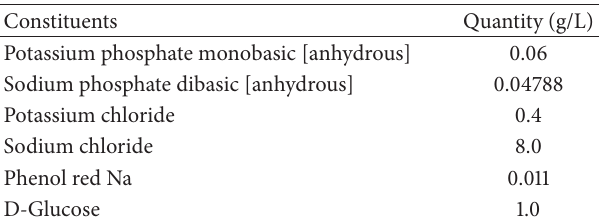
Table 2: Chemical composition of Hank’s balanced salt solution